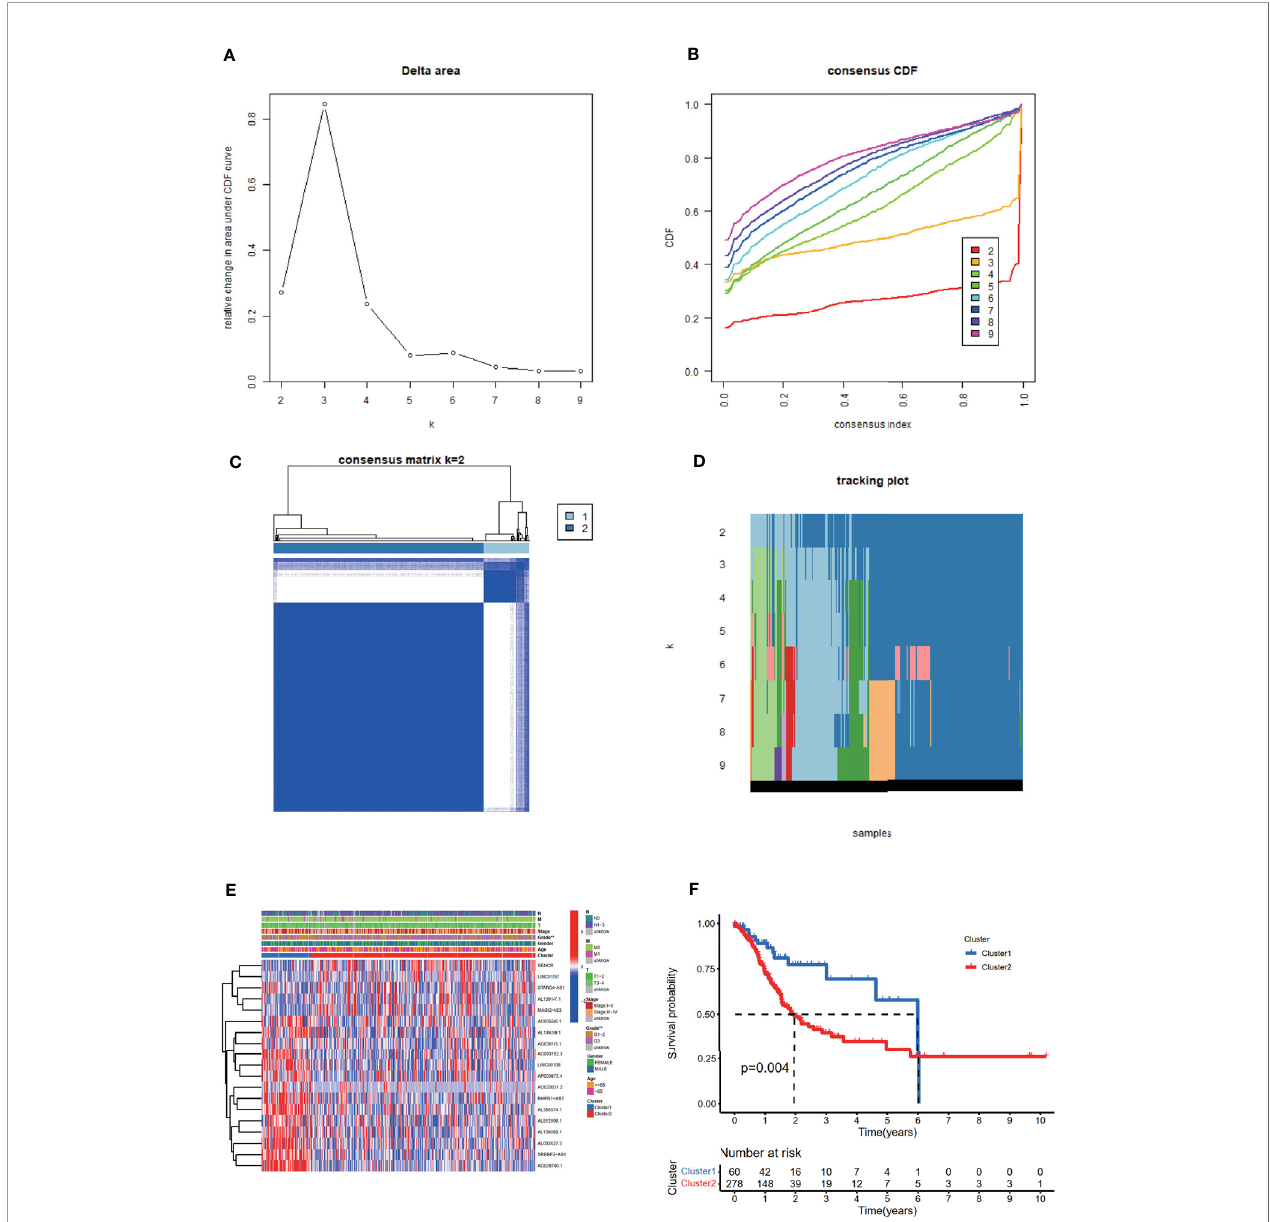
FIGURE 3 | Consistent cluster analysis of patients with STAD based on 19 prognostic m 6 A-related lncRNAs. (A) The consistency clustering cumulative distribution function (CDF) when k is between 2 and 10. (B) The relative change of the area under the CDF curve from 2 to 10 of k (C) At k = 2, the correlation between groups. (D) The distribution of the sample when k is between 2 and 10. (E) The distribution of clinicopathological characteristics and the expression of 19 prognostic m 6 A- related lncRNAs in clusters I and II. ** p < 0.01. (F) Comparison of Kaplan-Meier overall survival (OS) curve for STAD patients in clusters I and